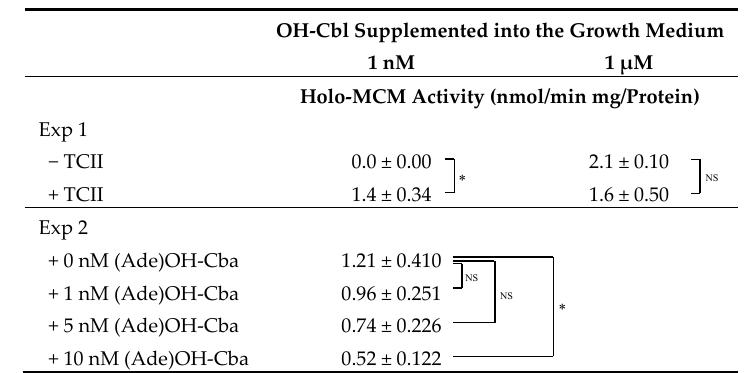
Table 5. Effects of addition of (Ade)OH-Cba on the activity of holo-MCM in cells grown in the presence of TCII and OH-Cbl.